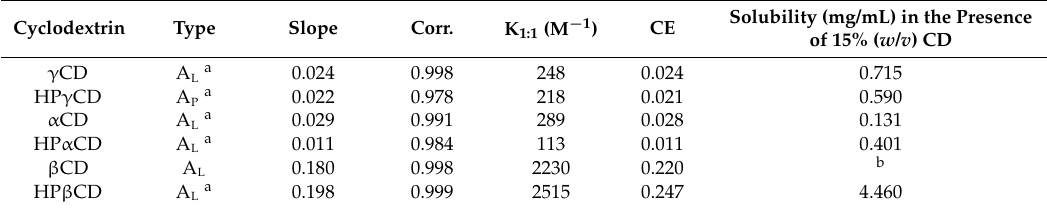
Table 3. Values of the apparent stability constant (K 1:1 ) and complexation efficiency